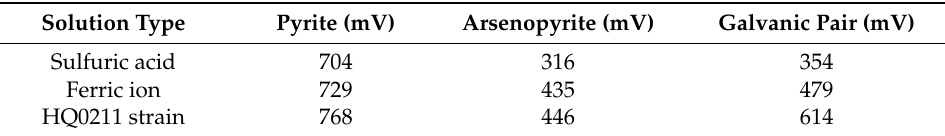
Figure 2. The exposed surfaces of pyrite ( a ), arsenopyrite ( b ), and the pyrite–arsenopyrite galvanic pair electrode ( c ). Table 1. The mean open circuit potentials (OCPs) of pyrite, arsenopyrite, and the galvanic pair in the investigated solutions.